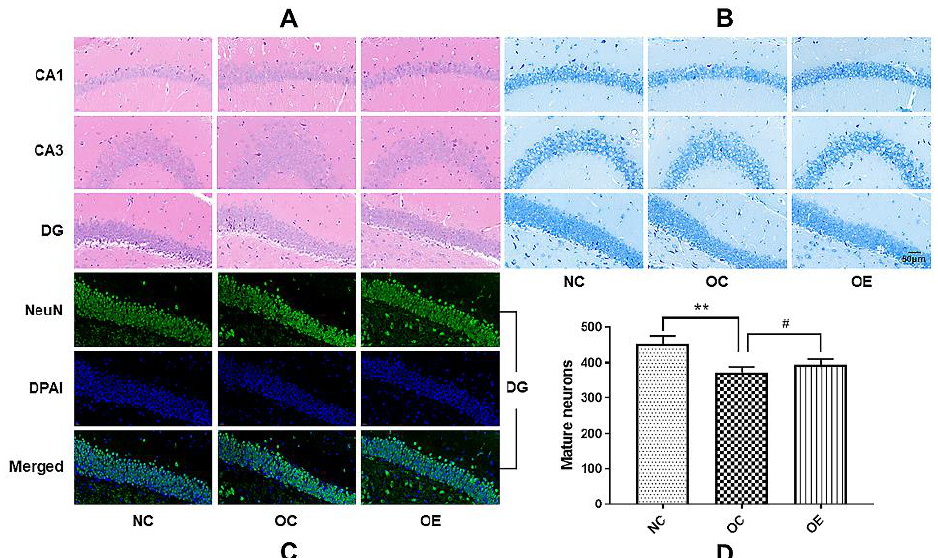
Figure 3. Representative images for the HE, Nissl, and NeuN staining of hippocampal tissues. All data were presented as mean ± standard deviation (M ± SD) ( n = 3 mice per group). ( A ) HE staining of the CA1, CA3, and DG hippocampal regions of the mice from the NC, OC, and OE groups; ( B ) Nissl staining of the CA1, CA3, and DG hippocampal regions of the mice from the NC, OC, and OE groups; ( C ) NeuN staining of the DG hippocampal region of the mice from the NC, OC, and OE groups. All images were acquired under a 400× optical microscope. ( D ) Statistical analysis of mature neurons in the DG regions of hippocampal tissues from the NC, OC, and OE groups. Compared with the NC group, ** p < 0.01; compared with the OE group, # p < 0.05.